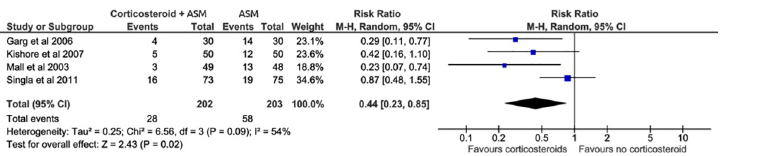
Fig 9. Forest plot of comparison. Corticosteroids versus no corticosteroids. Outcome: seizure recurrence.